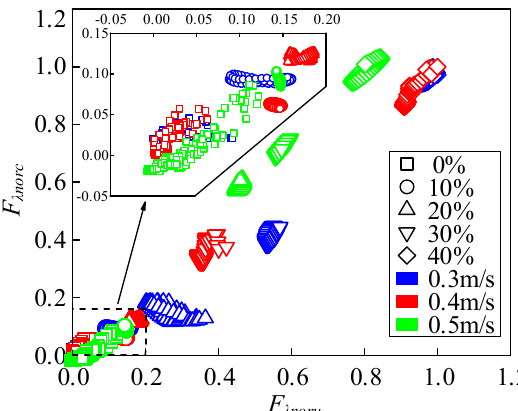
Figure 19. The distribution of the fault samples normalized by the MSN under working condition with no labeled training data: ( a ) The normalization scale corresponding to 0.3 m/s; ( b ) The normalization scale corresponding to 0.4 m/s.